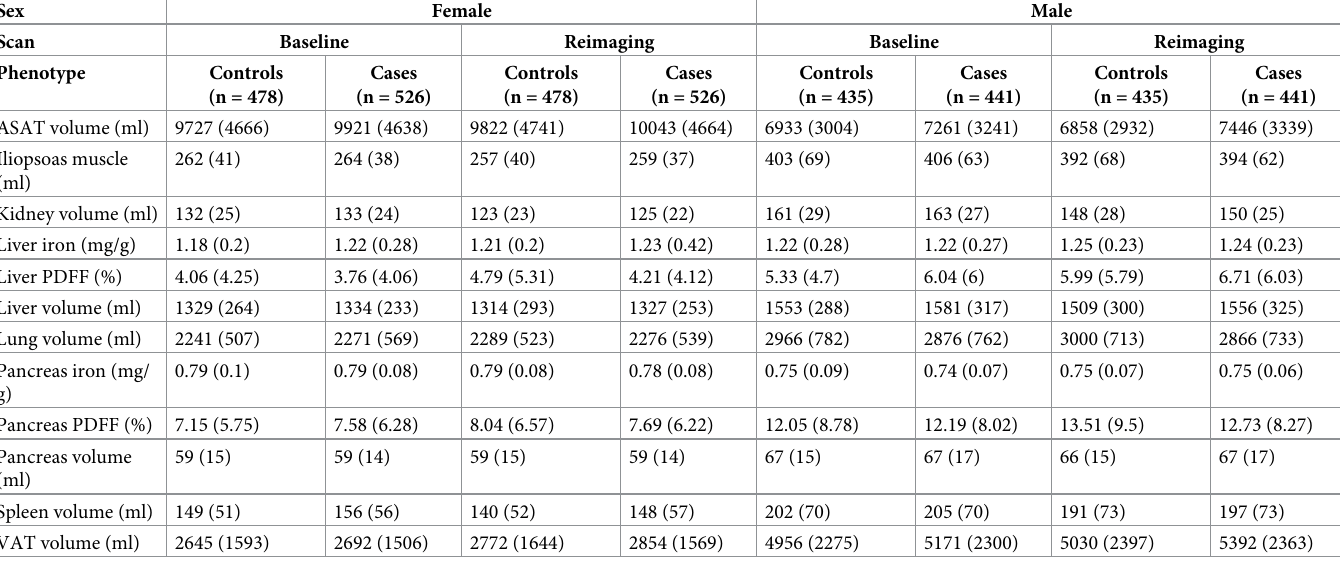
Table 2. Summary data on image-derived phenotypes for n = 913 SARS-CoV-2 positive cases and n = 967 SARS-CoV-2 matched controls, stratified by imaging visit and sex.